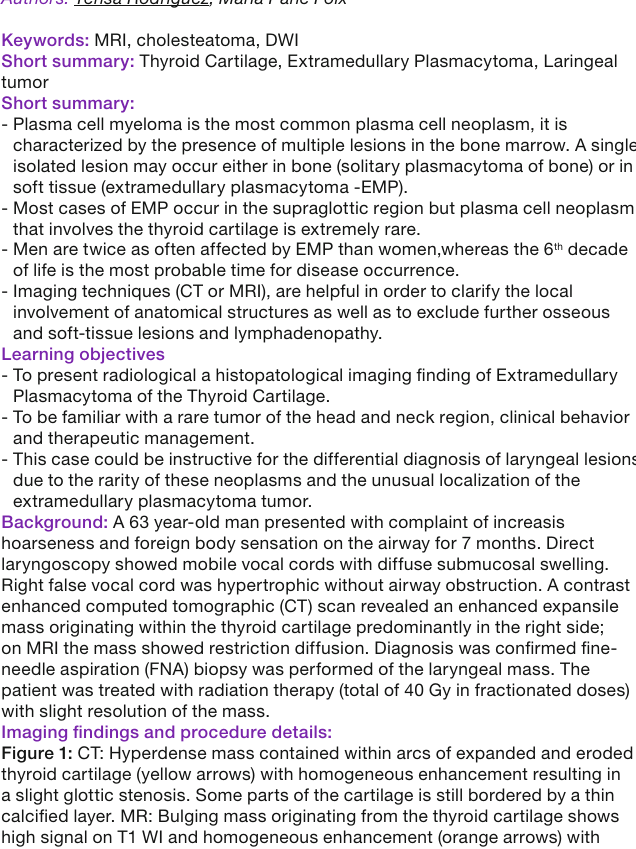
Figure 1: CT: Hyperdense mass contained within arcs of expanded and eroded thyroid cartilage (yellow arrows) with homogeneous enhancement resulting in a slight glottic stenosis. Some parts of the cartilage is still bordered by a thin calcified layer. MR: Bulging mass originating from the thyroid cartilage shows high signal on T1 WI and homogeneous enhancement (orange arrows) with restricted diffusión (green arrows). Figure 2: Microscopic pictures. H&E stain shows sheets of large atypical lymphoid cells with plasmacytic differentiation with abundant cytoplasm and large nuclei. ICH with positive staining for MUM1 and CD 138. Kappa light chains show a significant difference in staining intensity between kappa and lambda chains in favor of lambda chains demonstrating that the tumor is